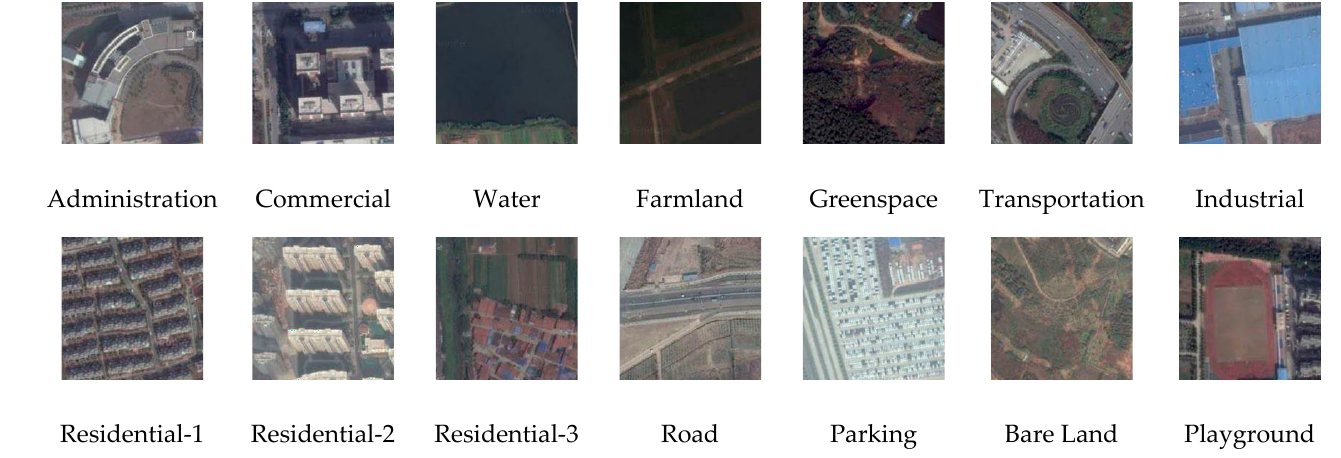
Figure 5. Examples of the WH-MAVS dataset.